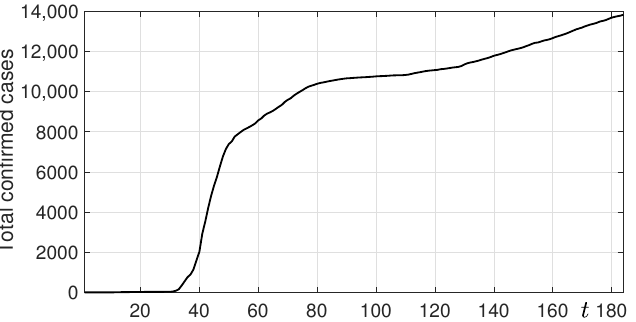
Figure 1. Total confirmed cases of COVID-19 in South Korea from 20 January to 17 July